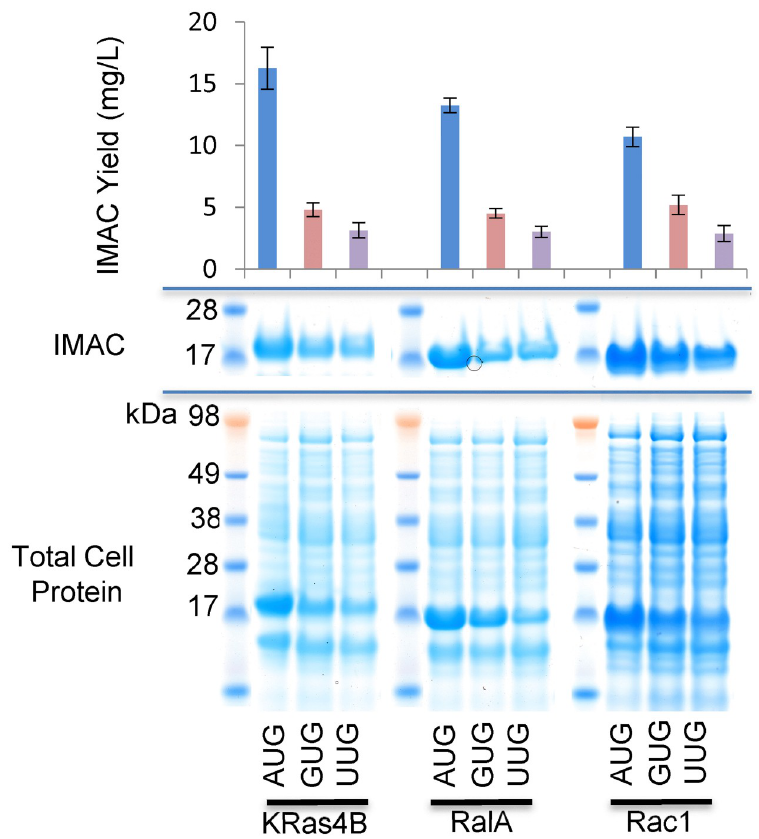
Fig 4. Solubility is not improved by altering the translational start codon. (A) SDS-PAGE and soluble fraction IMAC yield of codon optimized GTPase expression clones where the translational start codon was altered from the normal AUG to either GUG or